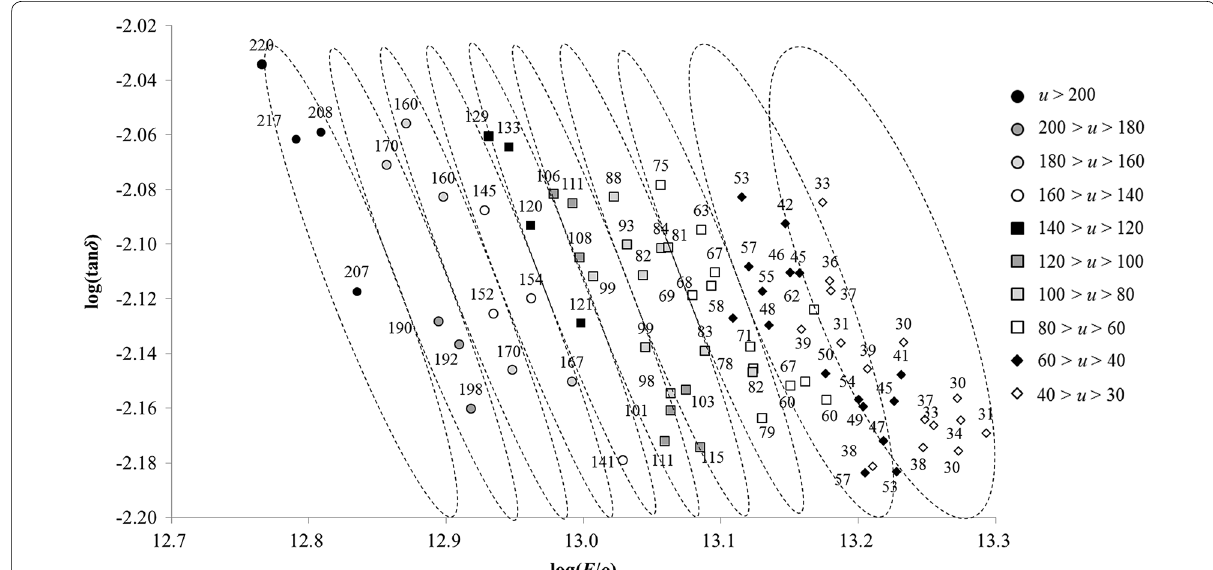
Fig. 3 Relationship between log ( E / ρ ) and log (tan δ ) for the Group C specimens during the drying process. The moisture contents, which were calculated via the oven-dry method, are provided next to each sample. The ellipses are drawn to show each plot group approximately aligned along a straight line with a certain